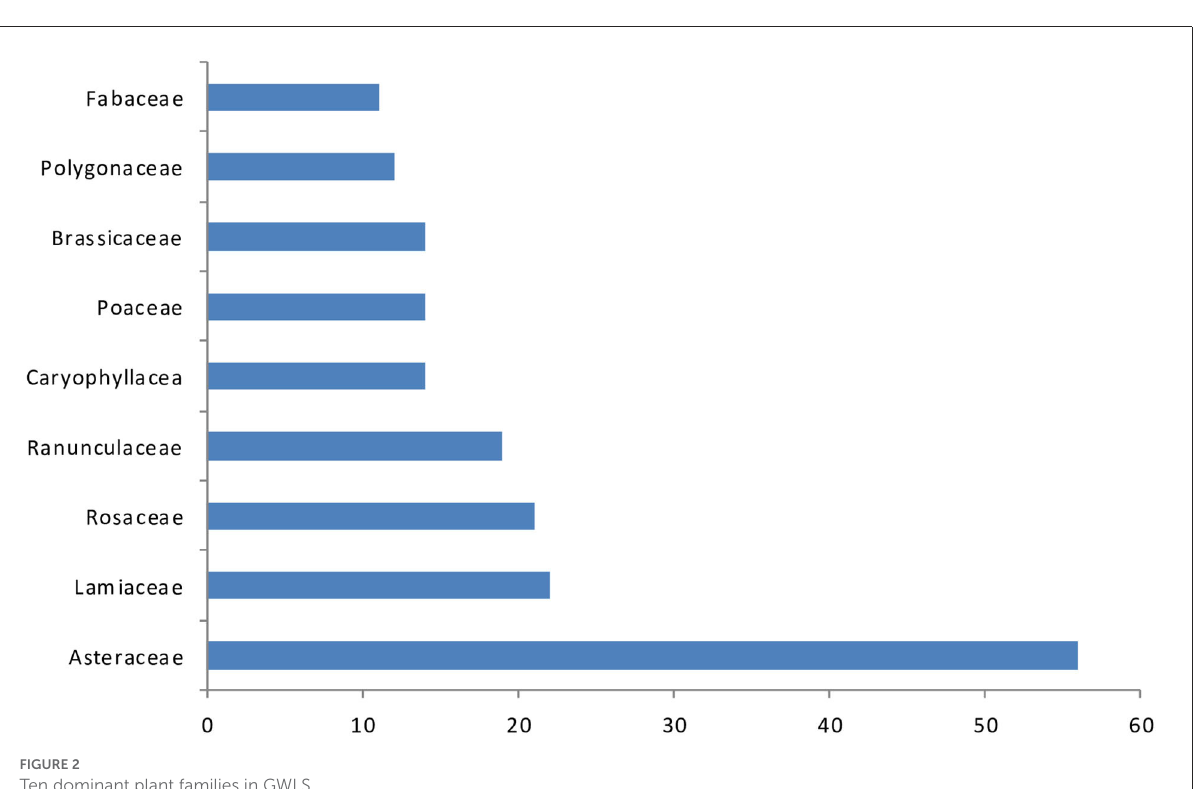
FIGURE2 Ten dominant plant families in